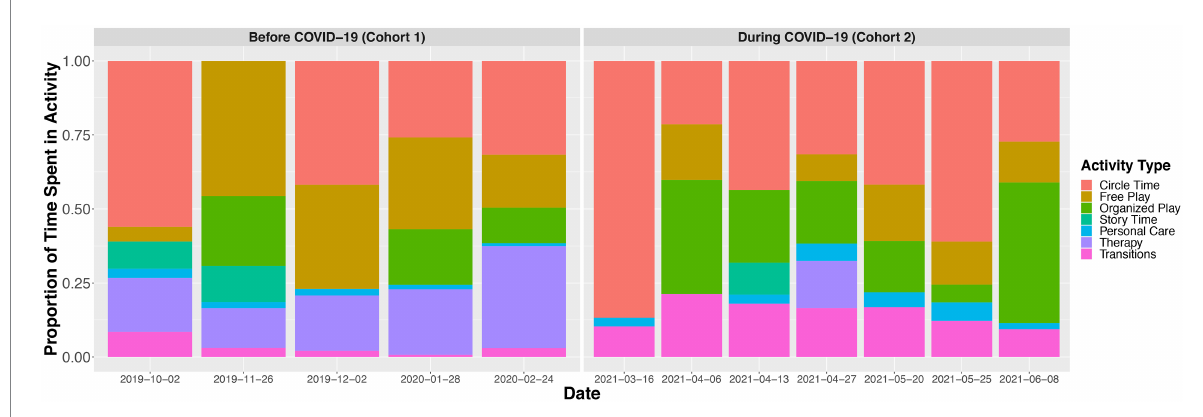
FIGURE 1 Proportion of time children spent in each activity context during each recording session. Children during COVID-19 were not required to wear masks during meal times (e.g., breakfast, snack time) or during outside play. Vocalizations that occurred during either meal time or outside play were excluded from analyses for both cohorts of children. The mean duration of meal time was 60.68 min (SD = 12.13) in the cohort observed before COVID-19 (Cohort 1) and 47.61 min (SD = 14.61) in the cohort observed during COVID-19 (Cohort 2). The mean duration of outside play was 35.16 min (SD = 18.30) in the cohort observed before COVID-19 (Cohort 1) and 56.70 min (SD = 16.45) in the cohort observed during COVID-19 (Cohort 2). Organized play includes periods in which children choose to work in stations in small groups led by a teacher doing pre-structured activities such as art projects. Personal care includes hand-washing and going to the bathroom. Not all children in the classroom attended therapy during a given recording session, thereby, the time spent in therapy reflects an average of the children who attended therapy during that recording